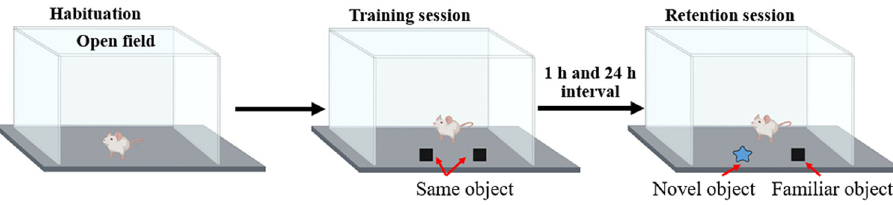
Figure 3. Representative procedure for object recognition test.